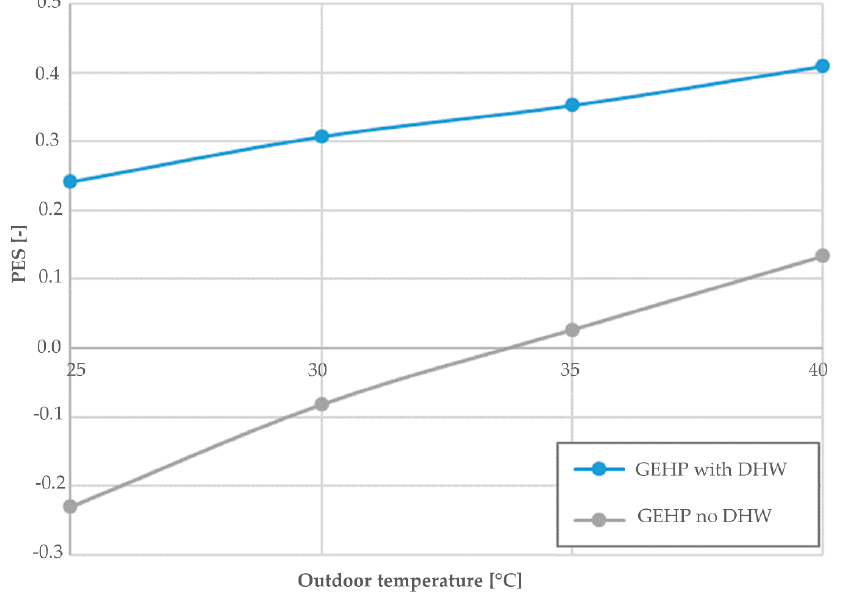
Figure 26. PES of GEHP with and without DHW vs. EHP-based system as a function of outdoor air temperature.